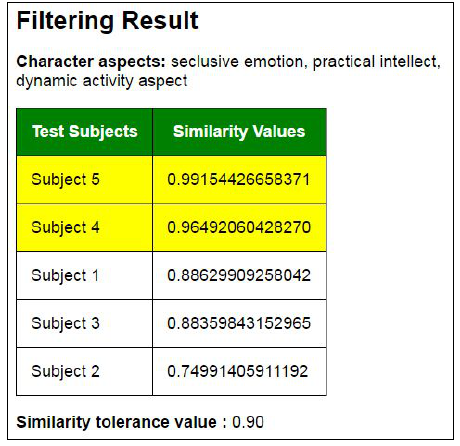
Fig. 5. Filtering result for seclusive emotion, practical intellect, and dynamic activity aspects